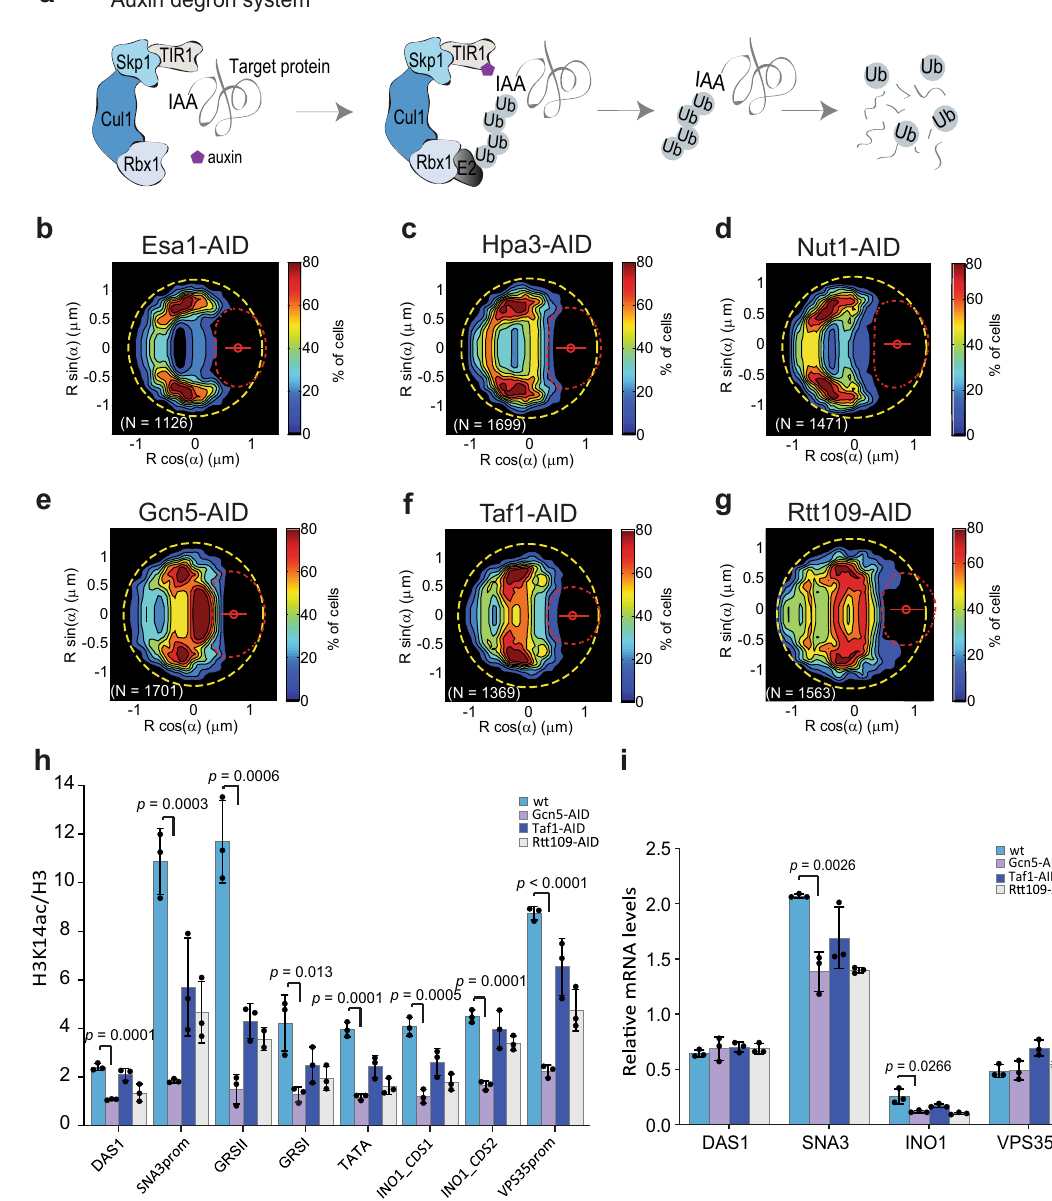
Fig. 4 | Speci fi c histone acetyltransferases (HATs) are required for active INO1 localization. a Schematic representation of the auxin-inducible degron (AID) system used to deplete targeted HAT catalytic subunits for degradation in the presence of auxin. b – g INO1 probability maps obtained from the analysis of thousandsofnucleiinstrainswithdifferentHATstaggedwiththeAIDdegronand grownintheabsenceofinositol(active). b – d HAT-AIDtaggedstrainswherethere is no effect on the statistical distribution of the INO1 locus after treating the cells with auxin. e – g HAT-AID tagged strains where the addition of auxin results in disruption of the INO1 locus relocalization pattern to the nuclear periphery. h H3K14ac enrichment around and within the active INO1 gene, as determined by